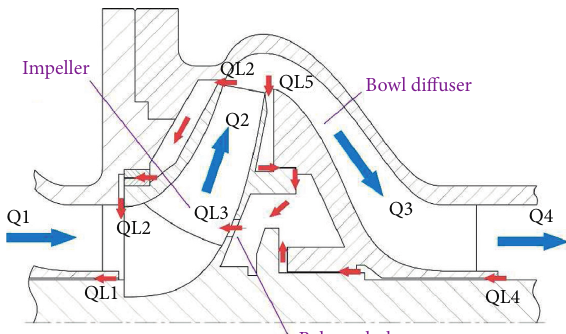
Figure 3: Leakage flow in the second stage of the slurry